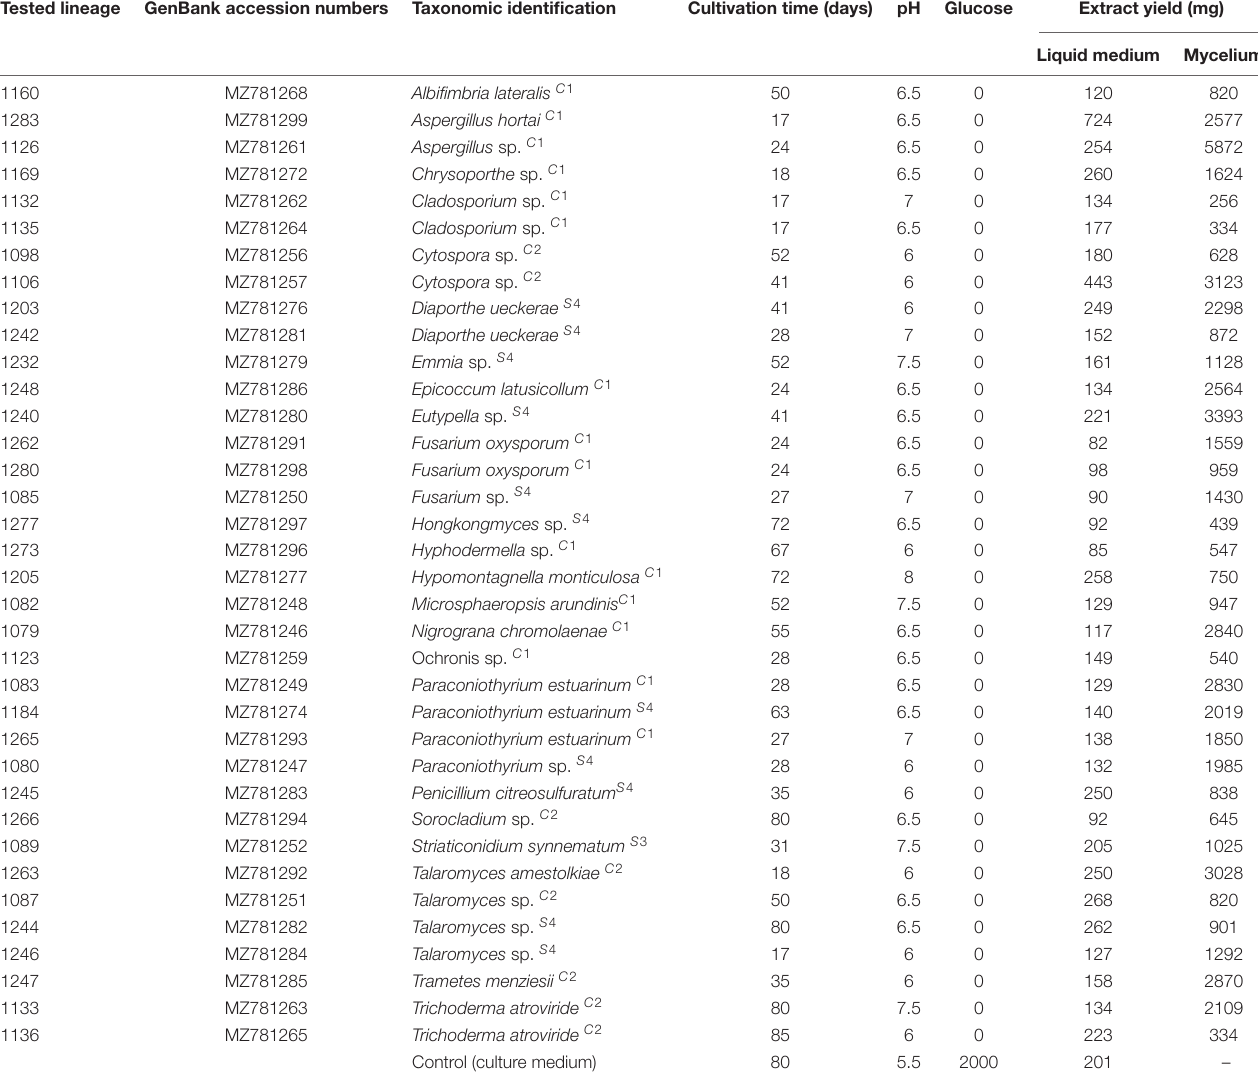
TABLE 1 | Crude extracts of 36 fungi isolated from aquatic environments in the Amazonian municipalities of Coari and São Gabriel da Cachoeira used in the larvicidal tests against Aedes aegypti . Tested lineage GenBank accession numbers Taxonomic